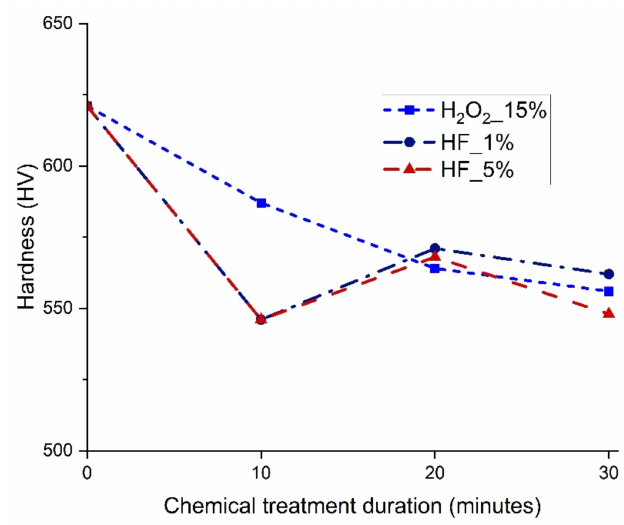
Figure 12. Microhardness of chemically treated